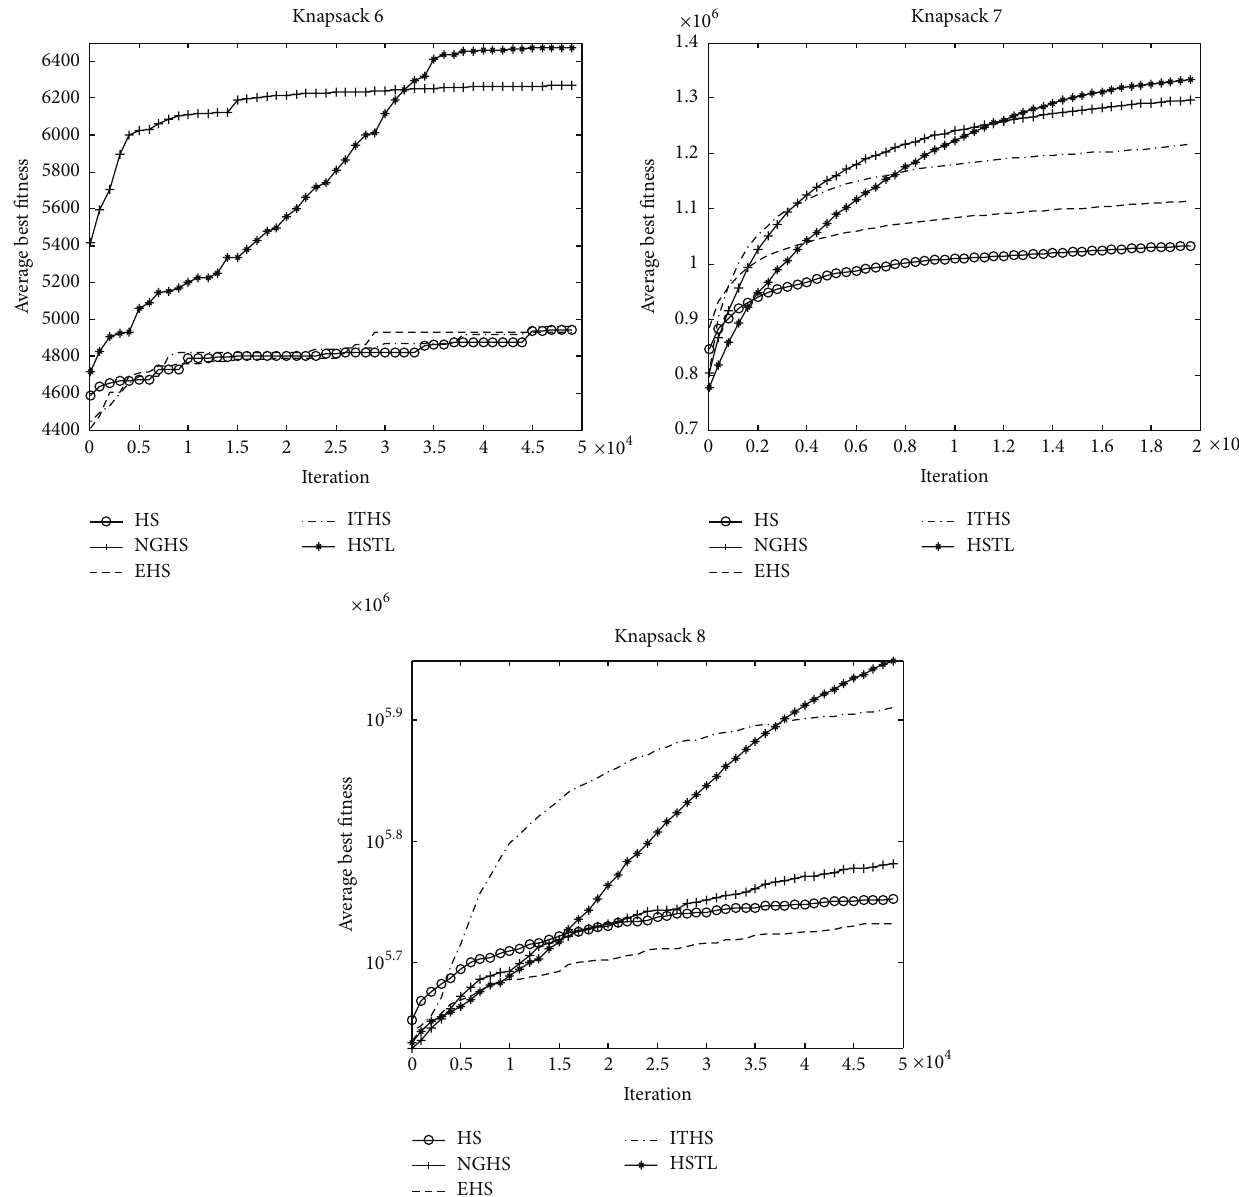
Figure 6: The convergence graphs of KP 6 –KP 8